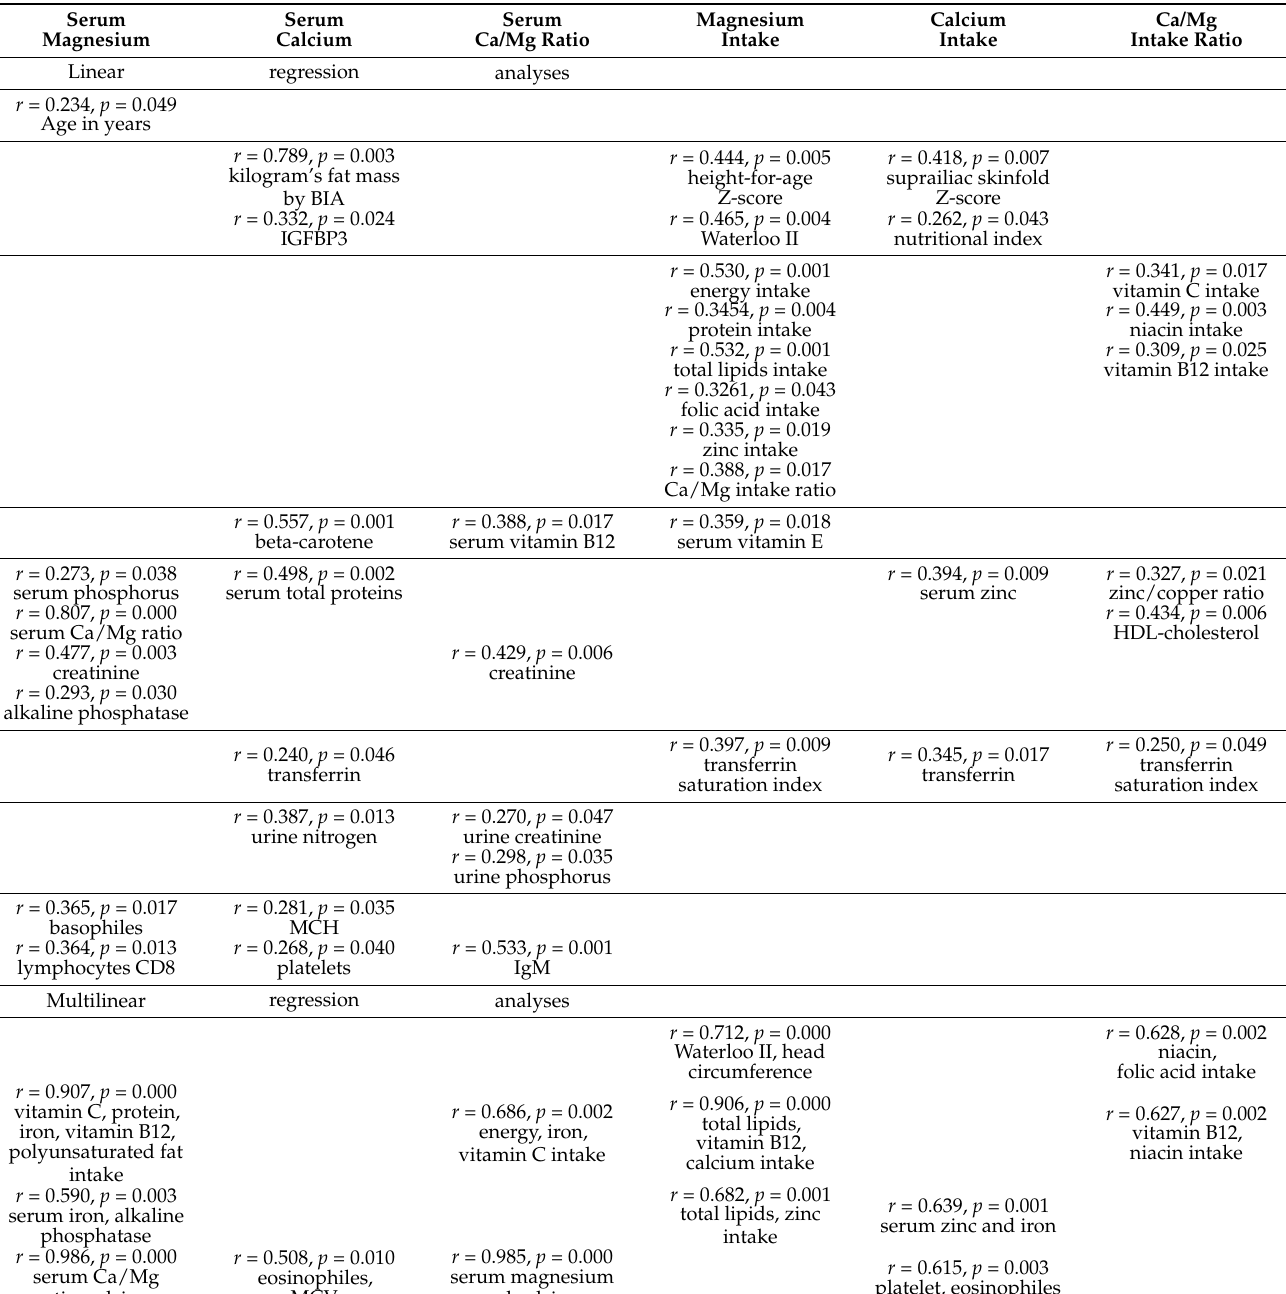
Table 4. Regression analysis between serum level and dietary intake of magnesium (Mg) and calcium (Ca), serum and dietary Ca/Mg ratios, and nutritional